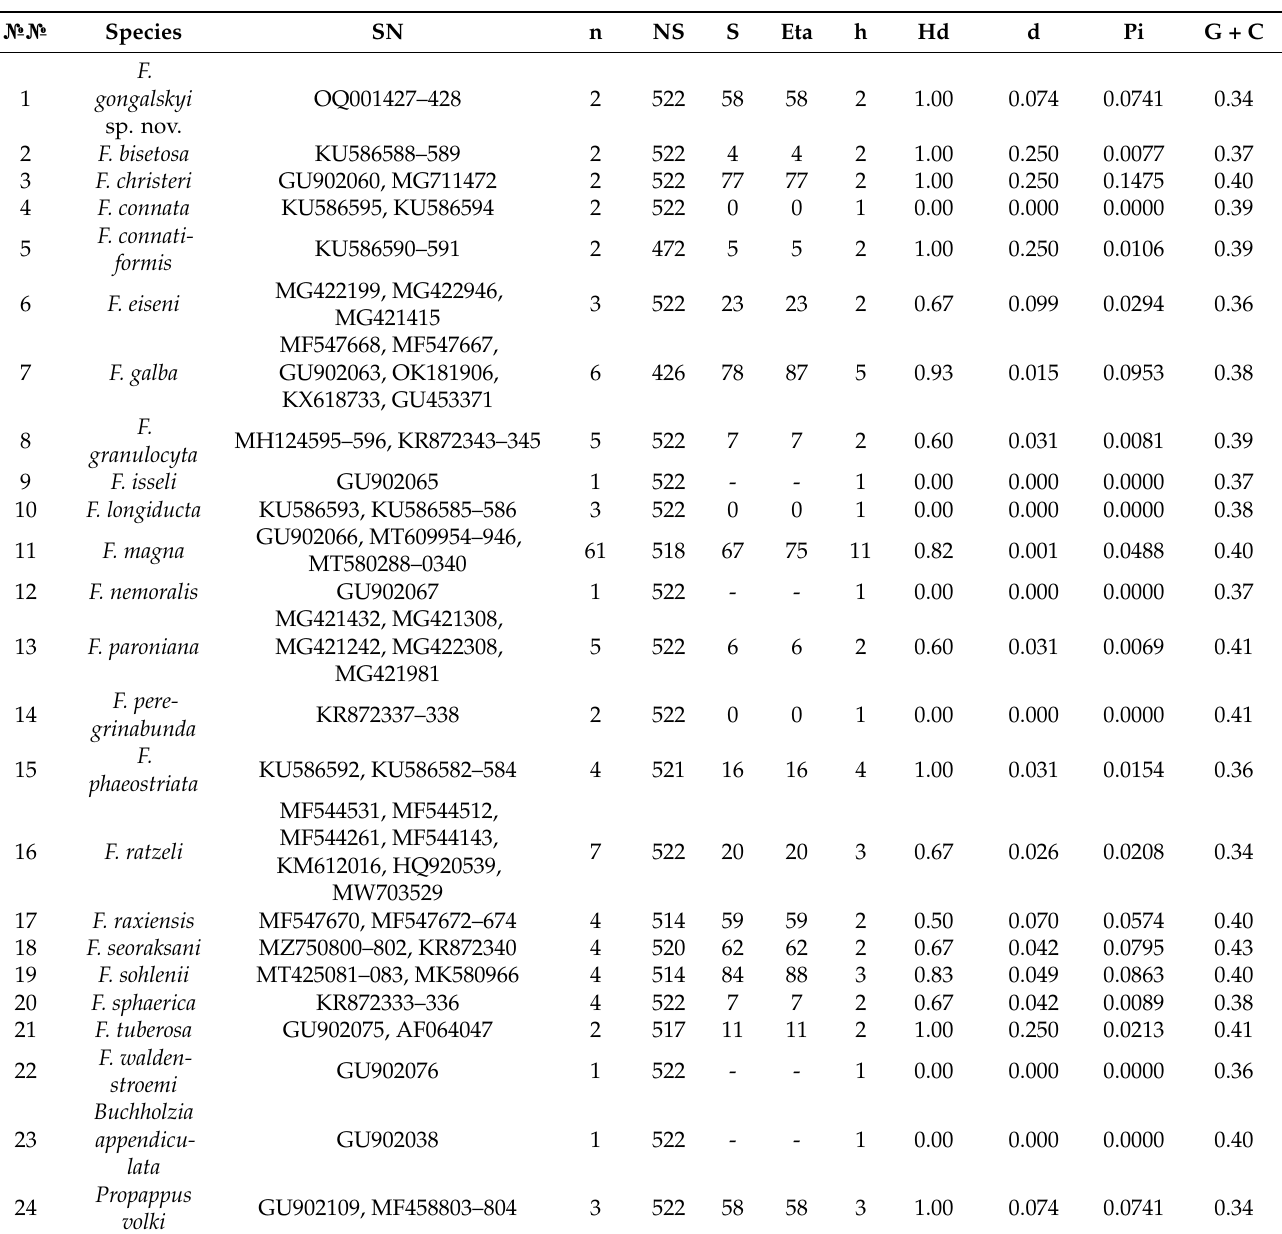
Table 2. Measures of genetic diversity: SN, COI sequences GenBank NCBI database numbers; n, number of sequences; NS, total number of sites (excluding sites with gaps/missing data); S, number of variable sites; Eta, total number of mutations; h, number of haplotypes; Hd, haplotype